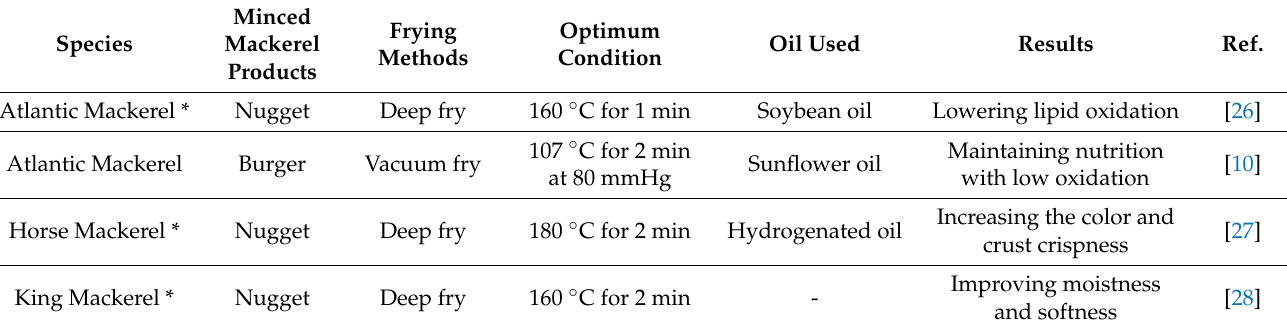
Table 4. Optimum conditions for minced mackerel